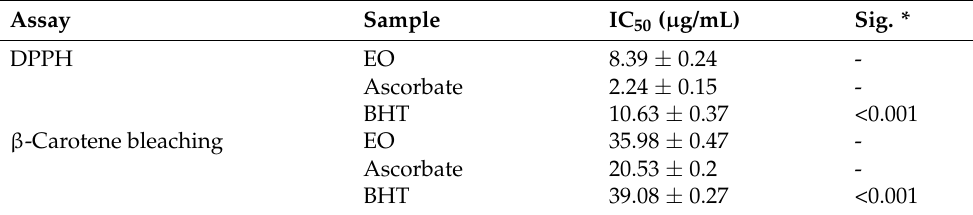
Table 2. Antioxidant activity of essential oil from the aerial parts of Teucrium luteum subsp. flavovirens growing wild in Tunisia. Results are reported as means ± SD. Assay Sample IC 50 ( µ g/mL) Sig. * DPPH EO 8.39 ± 0.24 - Ascorbate 2.24 ± 0.15 - BHT 10.63 ± 0.37 <0.001 β -Carotene bleaching EO 35.98 ± 0.47 - Ascorbate 20.53 ± 0.2 - BHT 39.08 ± 0.27